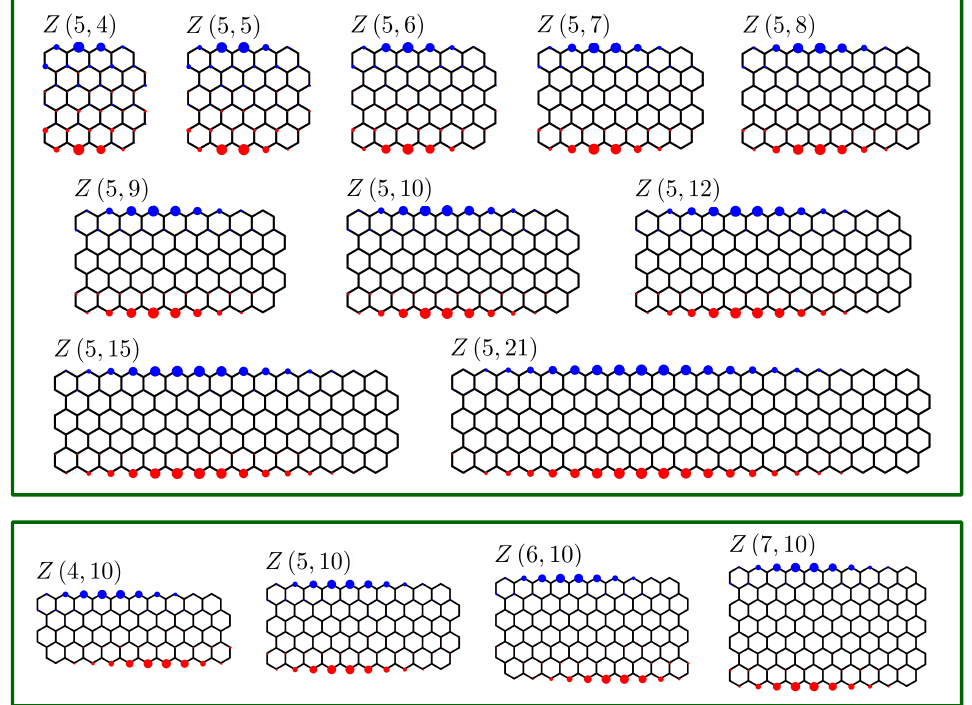
Figure 8. ZZ spin populations on carbon atoms in biradical structures of Z ( 5, n ) with n = 4,5,6,7,8,9,10,12,15 and 21 ( upper panel ) and Z ( m ,10 ) with m = 4,5,6 and 7 ( lower panel ). The computed ZZ spin population pattern is composed of two spin waves of opposite signs (depicted in blue and red) located at the zigzag edges of each multiple zigzag chain. The value of the spin population is visualized as a circle centered on each carbon atom. The predicted patterns very closely resemble the antiferromagnetic states of graphene nanoribbons discovered previously in quantum mechanical calculations; for more details, see